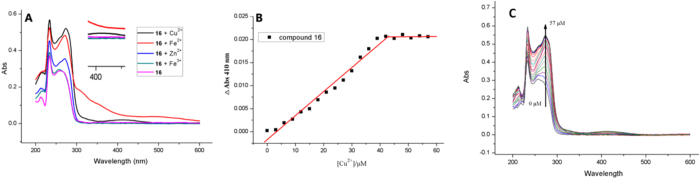
Metal-chelating properties of compound 16.(A) The UV spectrums of compound 16 (20 μM) alone and in the presence of CuSO4 (20 μM), FeSO4 (20 μM), Fe2(SO4)3 (20 μM), or ZnCl2 (20 μM) in 30% (v/v) ethanol/buffer (20 mM HEPES, 150 mM NaCl, pH = 7.4). (B) The determination of the stoichiometry of 16 (40 μM)-Cu2+ complex by molar ratio method. A breakpoint was observed at 1:1 ratio. The concentration of compound 16 was 40 μM. (C) UV-vis titration of compound 16 (40 μM) with Cu2+ in 30% (v/v) ethanol/buffer (20 mM HEPES, 150 mM NaCl, PH = 7.4). The concentration of Cu2+ was varied from 0 to 57 μM.